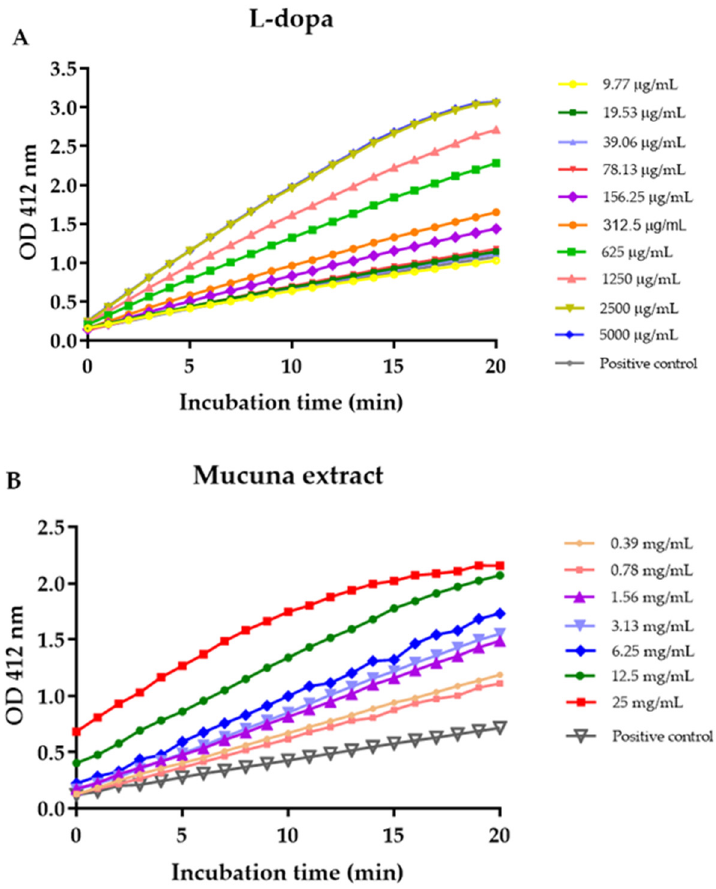
Figure 4. Plots of average O.D. readings subtracted from the mean blank (no enzyme) of each time point from its respective mean sample time points vs. time in the presence of ( A ) L-dopa and ( B ) M. pruriens seed extract.